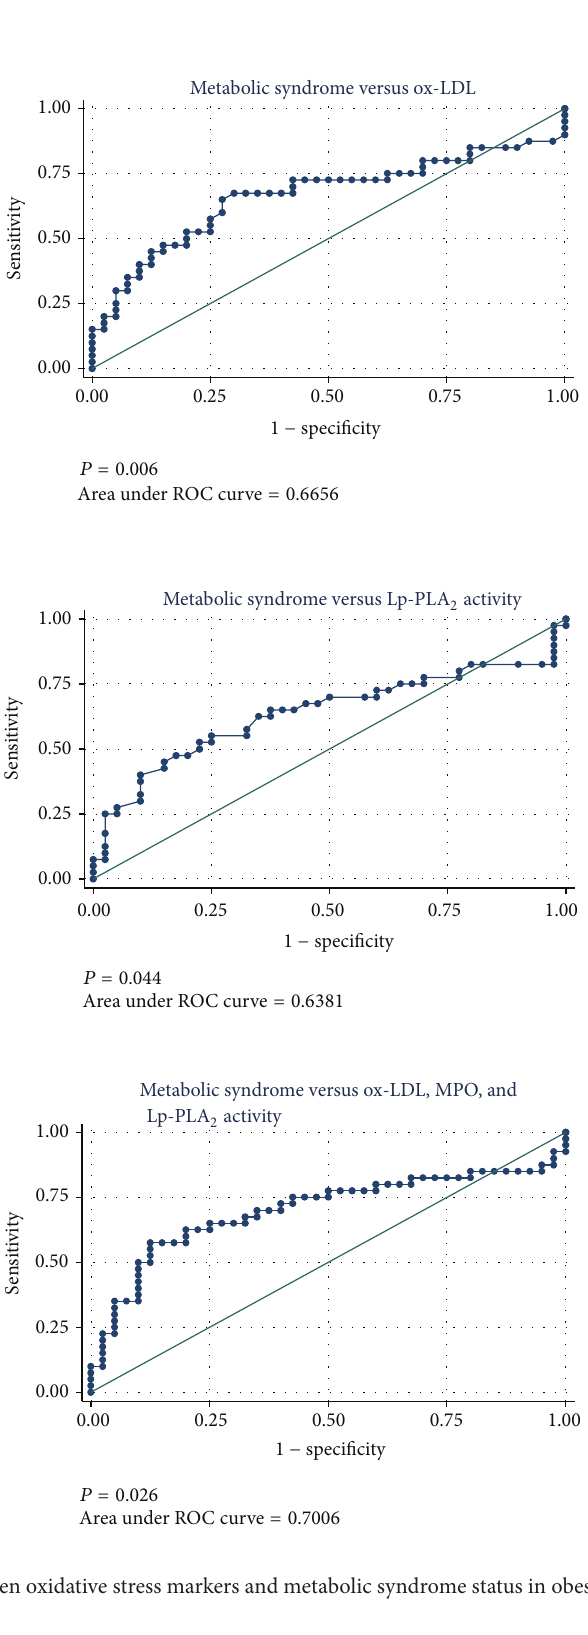
Figure 3: Relationship between oxidative stress markers and metabolic syndrome status in obese adults using ROC